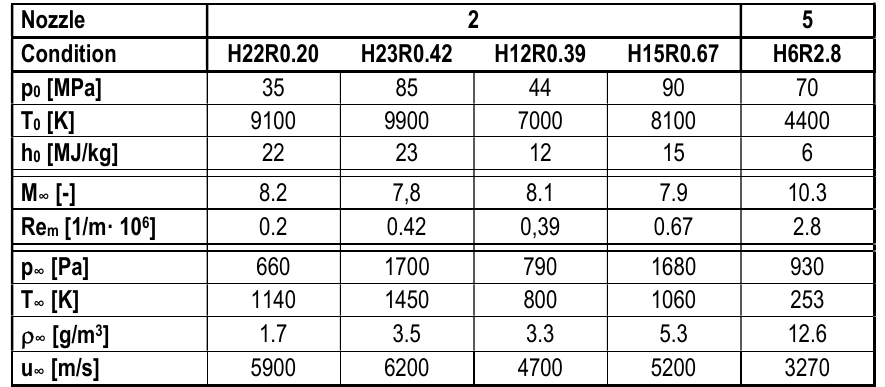
Table 1: Operating conditions using nozzle 2 and 5. The former condition nomenclature is from left to right I, II, III, IV and XXXI.